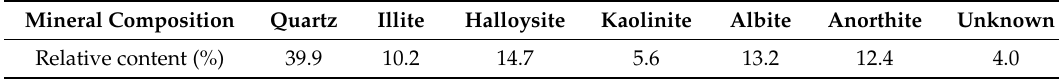
Figure 2. X-ray di ff raction spectrum for silty clay. Figure 2. X-ray diffraction spectrum for silty clay. Table 1. Relative mineral contents of silty Table 1. Relative mineral contents of silty clay.